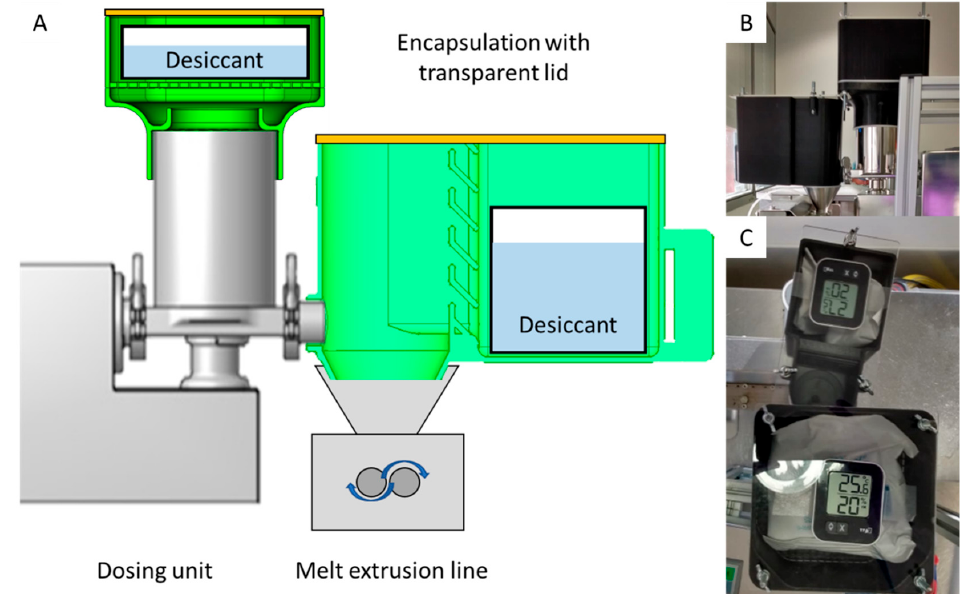
Figure 7. Encapsulation of essential components of a melt extrusion line to prevent water absorption by polymers. ( A ) Schematic illustration of point moisture encapsulation. ( B ) Encapsulation of the flat-bottomed feeder and filling area of the melt extrusion line. ( C ) Encapsulation with introduced desiccant, ambient air monitoring by means of a thermohygrometer, and the possibility of optical monitoring of the filling area of the melt extrusion line.